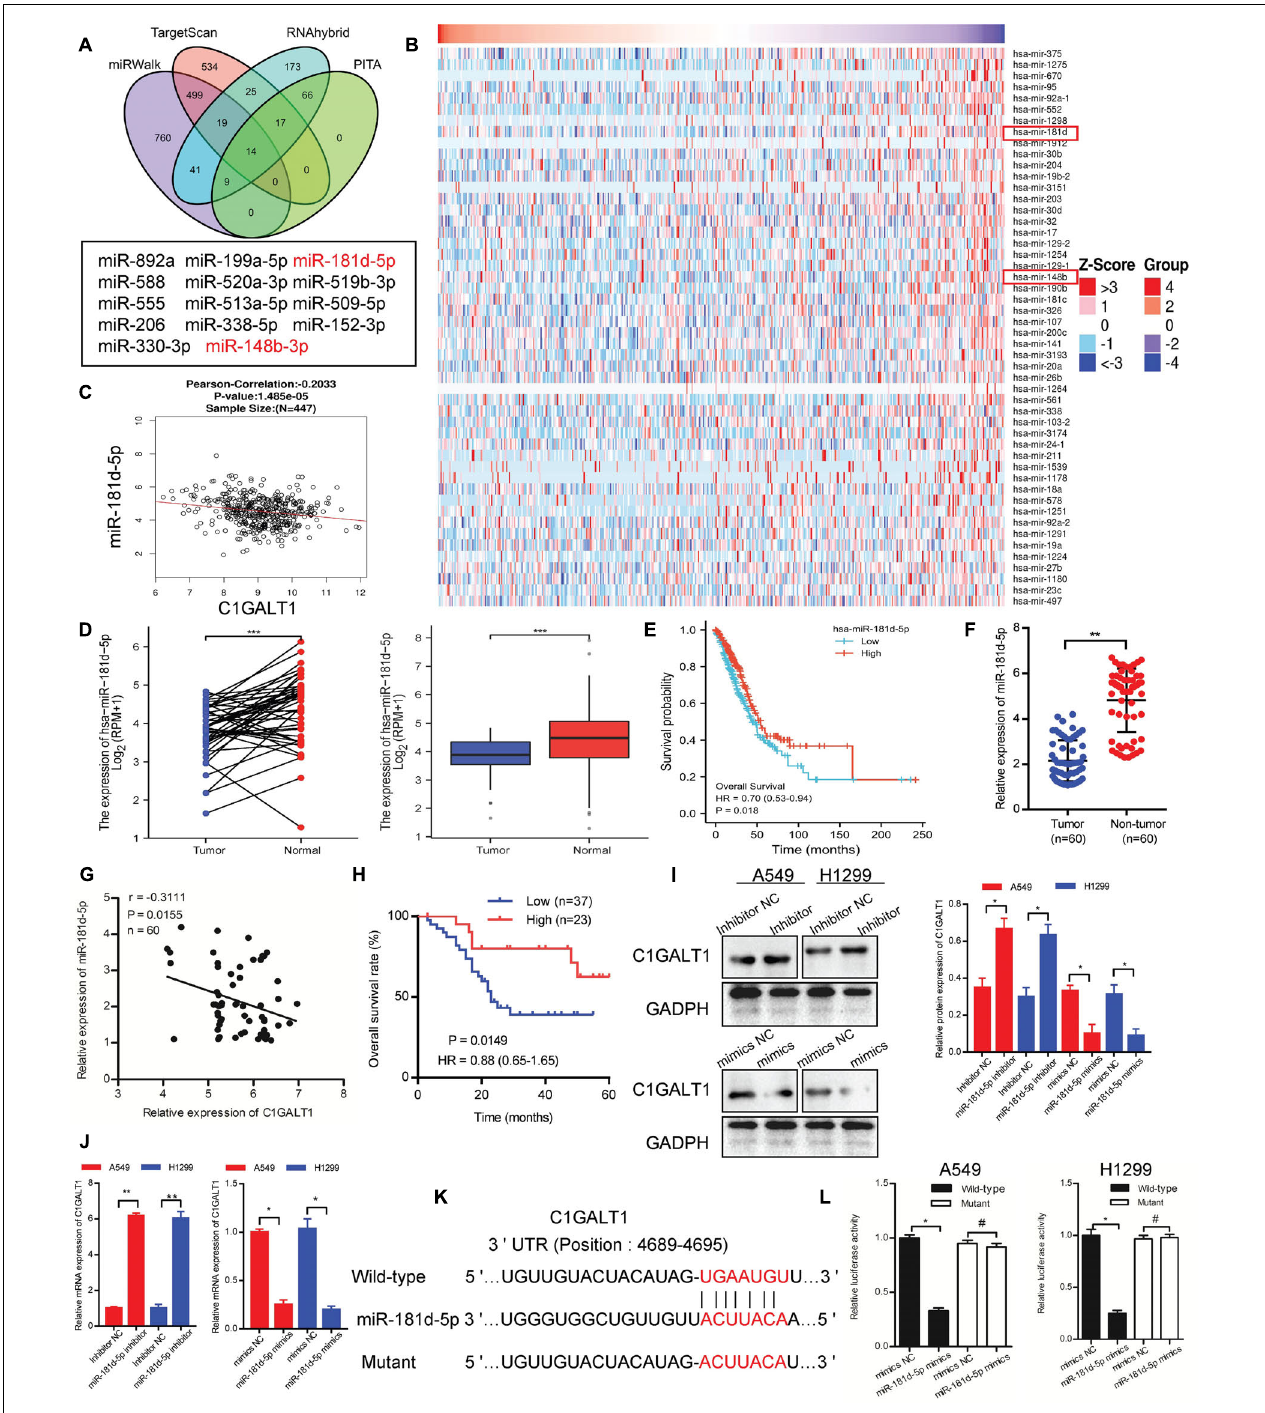
FIGURE 5 | C1GALT1 is directly downregulated by miR-181d-5p in LUAD. (A) Venn diagrams showing the number of potential miRNAs targeting the 3’ UTR of C1GALT1. (B) Heat maps showing the top 50 miRNAs negatively correlated with C1GALT1 in LUAD. (C) Correlation between miR-181d-5p and C1GALT1 in TCGA-LUAD samples. (D) miR-181d-5p expression in paired (left) or unpaired (right) LUAD tissues and normal lung tissues from the TCGA database. (E) Survival analysis of miR-181d-5p in LUAD from the TCGA database. (F) Analysis of miR-181d-5p expression by qPCR in clinical LUAD samples. (G) Pearson correlation analysis of miR-181d-5p with C1GALT1 expression in clinical LUAD samples. (H) Overall survival analysis of LUAD patients based on miR-181d-5p expression in clinical samples. (I,J) Analysis of C1GALT1 expression in LUAD cell lines after transfection with miR-181d-5p mimics or inhibitor by Western blot (I) and qPCR (J) . (K) The potential binding site of miR-181d-5p in the 3’UTR of C1GALT1. (L) Relative luciferase activity detection. Data are expressed as mean ± SD.* p < 0.05; ** p < 0.01; *** p < 0.001; # p > 0.05.